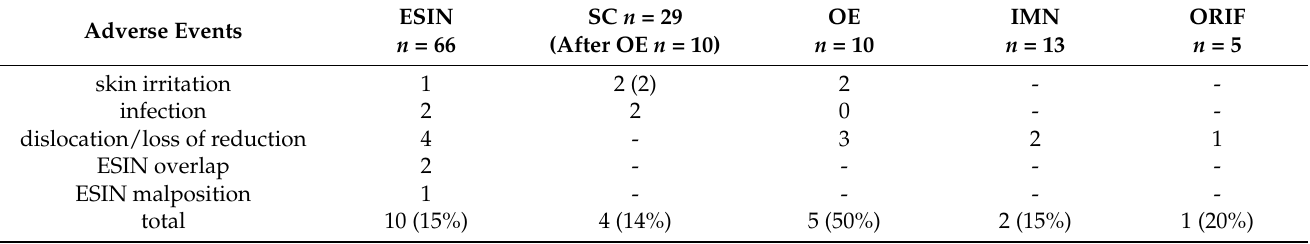
Figure 3. ( A ) Duration of hospital stay in days for the different treatment strategies of spica cast alone (SC), overhead extension followed by spica cast (OE), flexible intramedullary nailing (ESIN), intramedullary nailing (IMN) and open reduction and fixation (ORIF) with plate osteosynthesis. ( B ) Number of visits to the outpatient department among patients with the different treatment strategies of SC, OE, ESIN, IMN and ORIF. ( C ) Duration to callus formation in weeks under different treatment regimens: conservative treatment (cons.), flexible intramedullary nailing (ESIN), intramedullary nailing (IMN) and open reduction and internal fixation (ORIF) with plate osteosynthesis. ( D ) Duration to callus formation in weeks in the different fracture types: 32-D/4.1, 32-D/4.2, 32-D/5.1 and 32-D/5.2, according to the AO Pediatric Comprehensive Classification of Long Bone Fractures (AO-PCCF). ( E ) Duration of callus formation in weeks in the ESIN group in different body weight groups in kg. ( F ) Duration of callus formation in the ESIN group in weeks in different age groups. Differences between groups were significant, as indicated: * p < 0.05, ** p < 0.01, *** p < 0.001. Table 2. Summary of adverse events in the different treatment groups: flexible intramedullary nailing (ESIN), spica cast (SC) alone and after overhead extension (OE) and during overhead